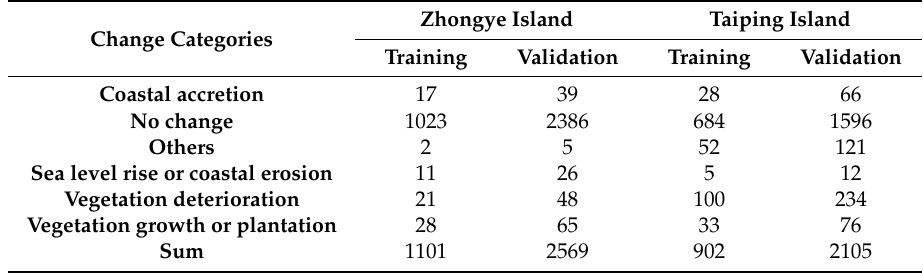
Table A4. The object sample numbers of all change categories in Zhongye Island and Taiping